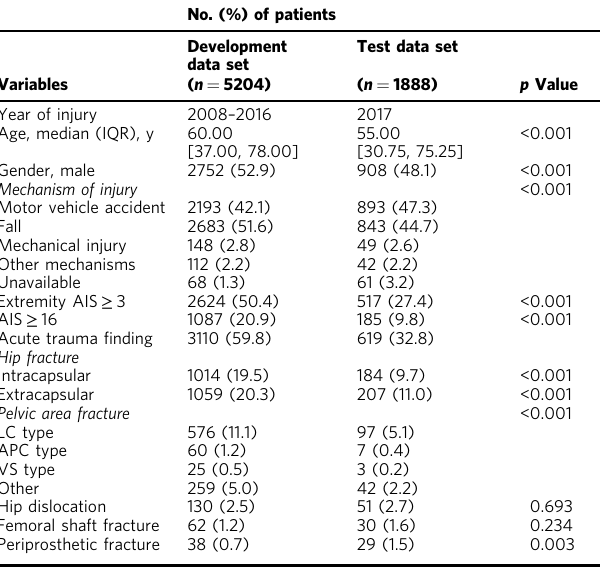
Table 1 Demographic data of development and test data set.